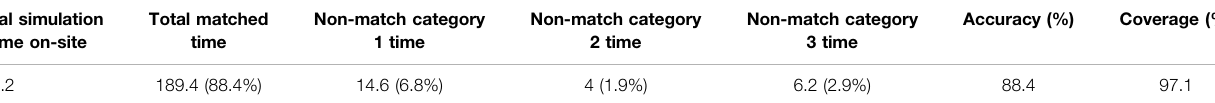
TABLE 3 | Summary of system accuracy and coverage (all times in minutes).